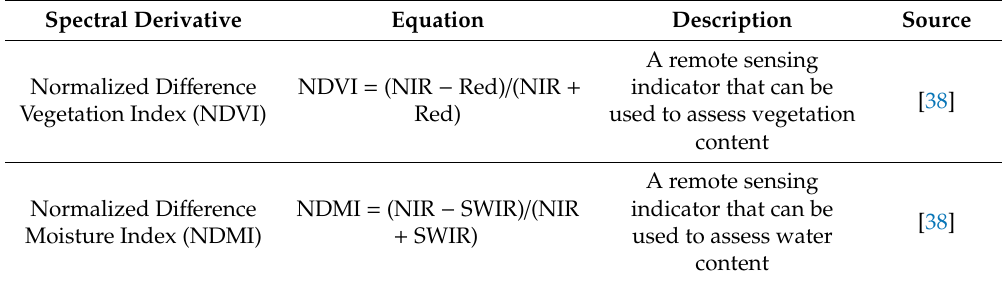
Table A1. Spectral / radar derivatives utilized in satellite detection modeling of